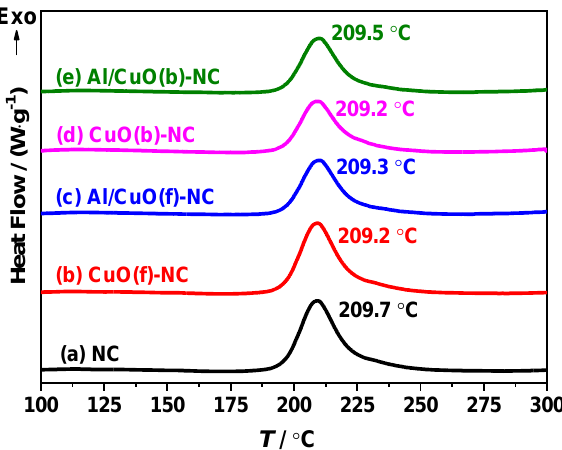
Figure 7. Differential scanning calorimetry (DSC) curves of NC, CuO(b)-NC, Al/CuO(b)-NC, CuO(f)- Figure 7. Di ff erential scanning calorimetry (DSC) curves of NC, CuO(b)-NC, Al / CuO(b)-NC, CuO(f)-NC, NC, and Al/CuO(f)-NC obtained at a heating rate of 10 °C·min −1 . and Al / CuO(f)-NC obtained at a heating rate of 10 ◦ C · min − 1 .